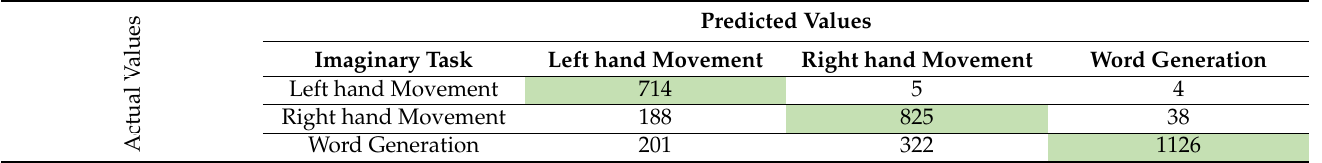
Table 6. Confusion matrix of subject 3.